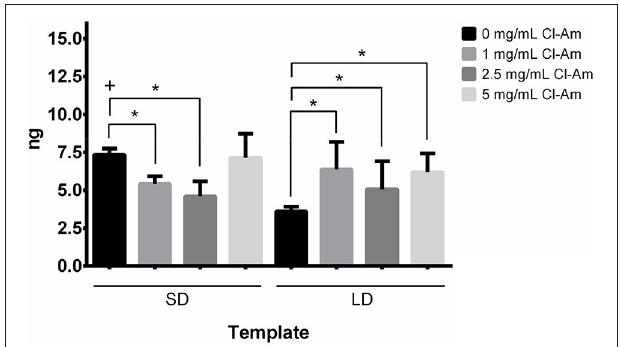
FIGURE 11 | PDO templates eluting Cl-Am modulate NETosis in vivo . Cl-Am attenuates NETosis as indicated by CitH3 on SD templates while increasing NETosis on LD templates. *Significant difference ( p < 0.05). + Significant difference between SD and LD templates ( p < 0.05) (mean ± std. dev., n =